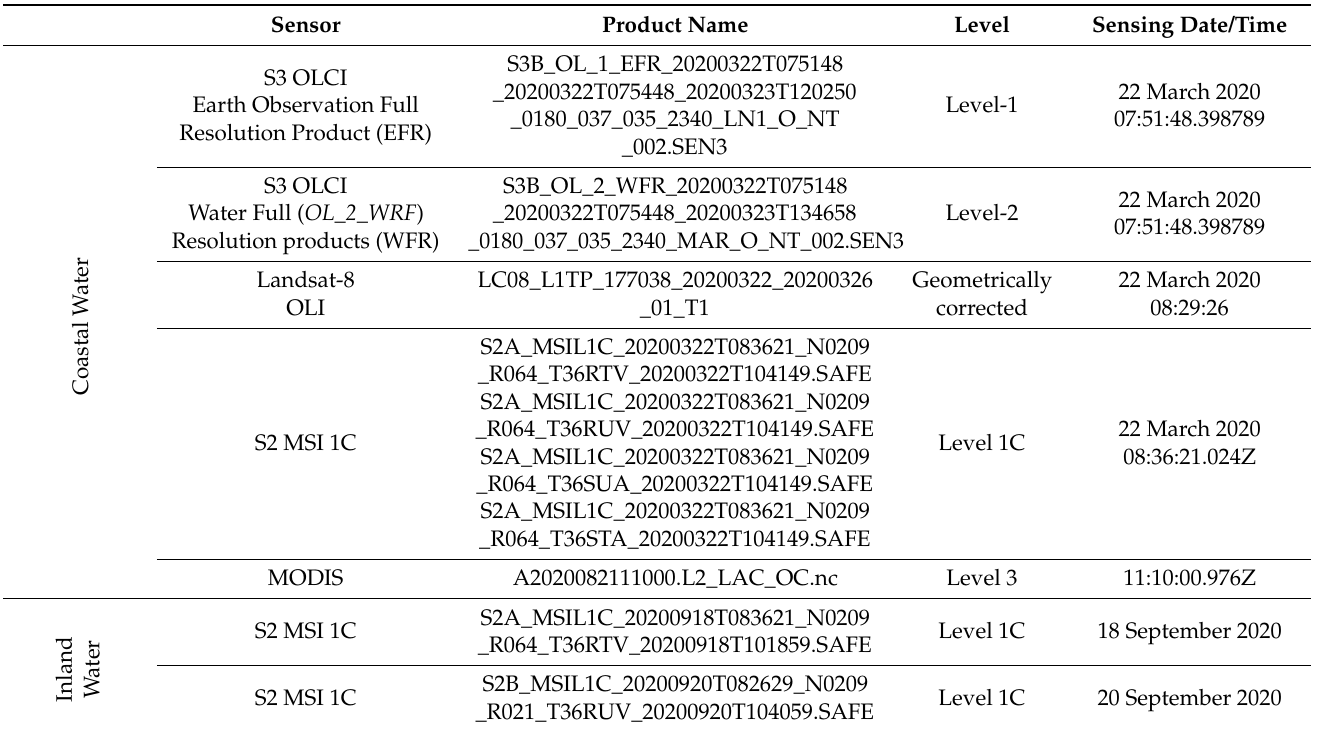
Table 1. Remote Sensing data acquired over North of the Nile Delta of Egypt.